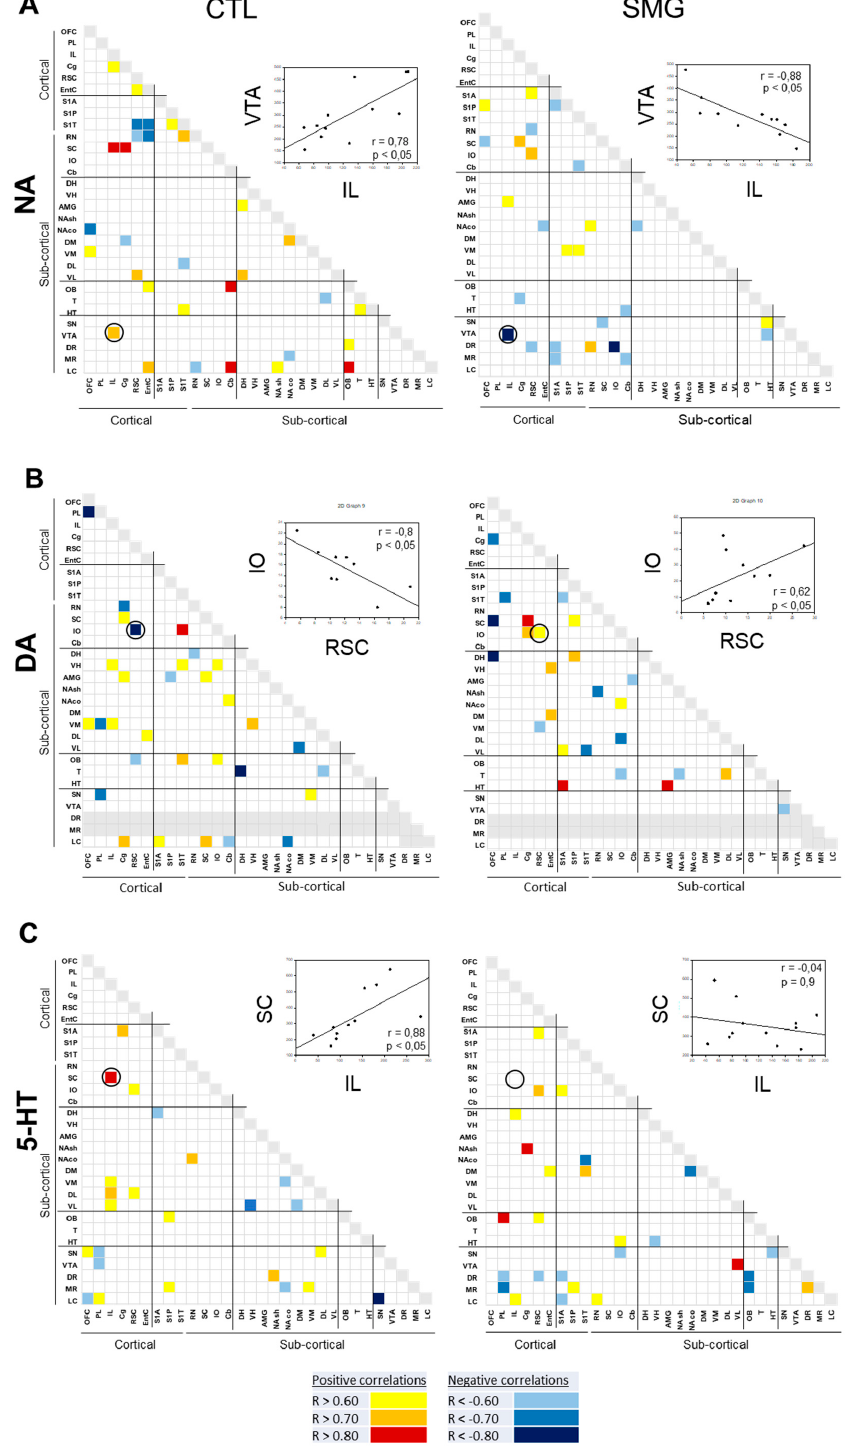
Figure 6. Correlograms for NA ( A ), DA ( B ), and 5-HT ( C ) for the CTL and SMG groups. Positive correlations are reported in yellow (r > 0.6) to red (r > 0.8). Negative correlations are reported in light blue (r < − 0.6) to deep blue (r < − 0.8). The insert illustrates a representative correlation between brain regions indicated by the circle. Only significant correlations ( p < 0.05) are